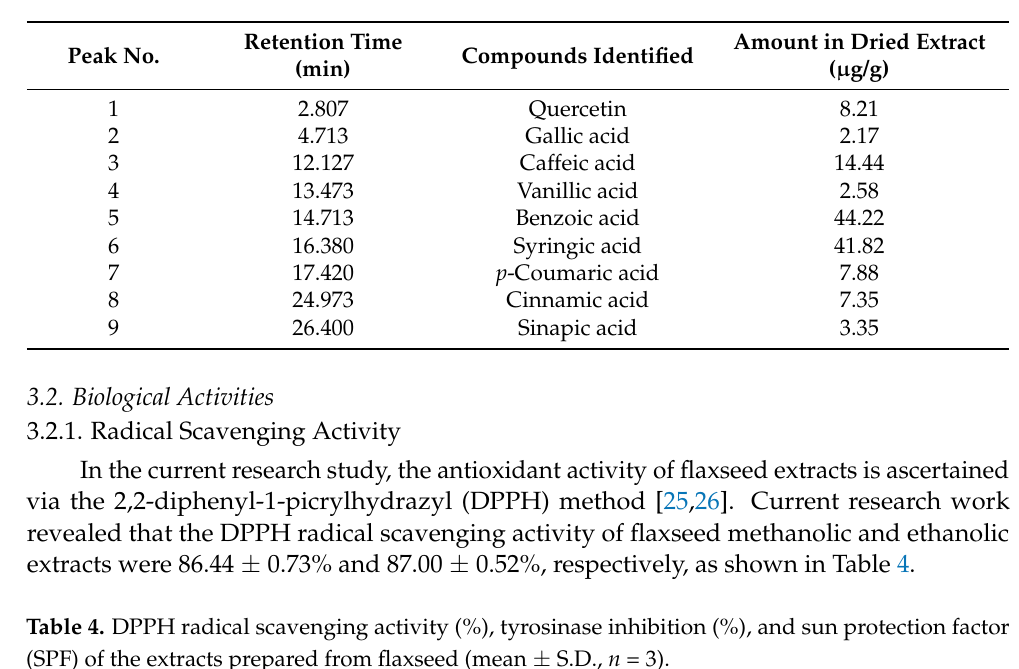
Table 3. Polyphenolic constituents ( µ g/g) of the ethanolic flaxseed extract determined by HPLC-UV at λ = 280 nm.